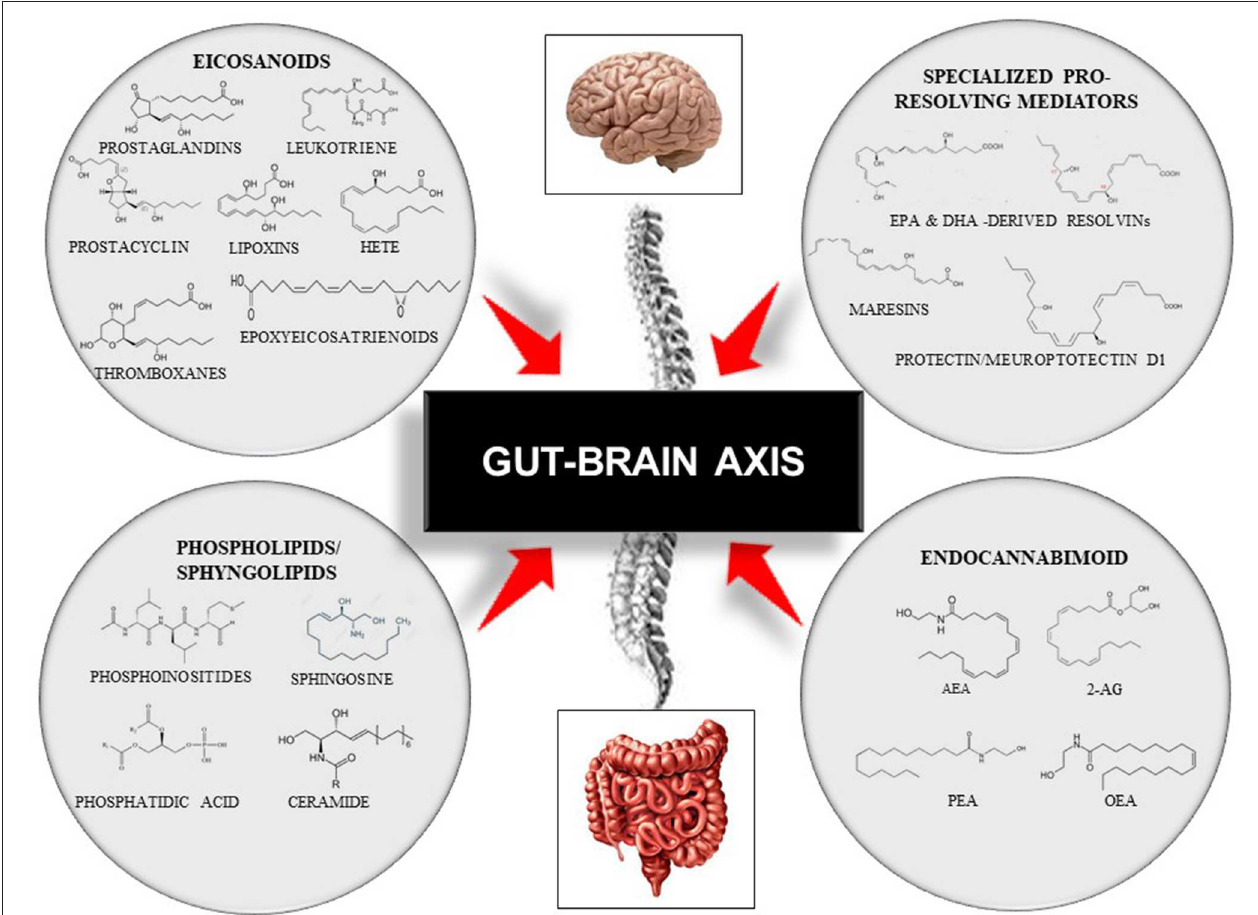
FIGURE 3 | Representative scheme of the gut–brain axis and the modulation by four families of bioactive lipids: the classical eicosanoids, the phospholipids/sphingolipids, the specialized pro-resolving lipid mediators, and, the endocannabinoid system. This figure does not intend to be an exhaustive description of all lipid members or each family sub-member. 2-AG, 2-Arachidonoylglycerol; AEA, Arachidonoylethanolamide; DHA, Docosahexaenoic Acid; EPA, Eicosapentaenoid Acid; HETE, Hydroxyeicosatetraenoids; OEA, Oleoilethanolamide; PEA,